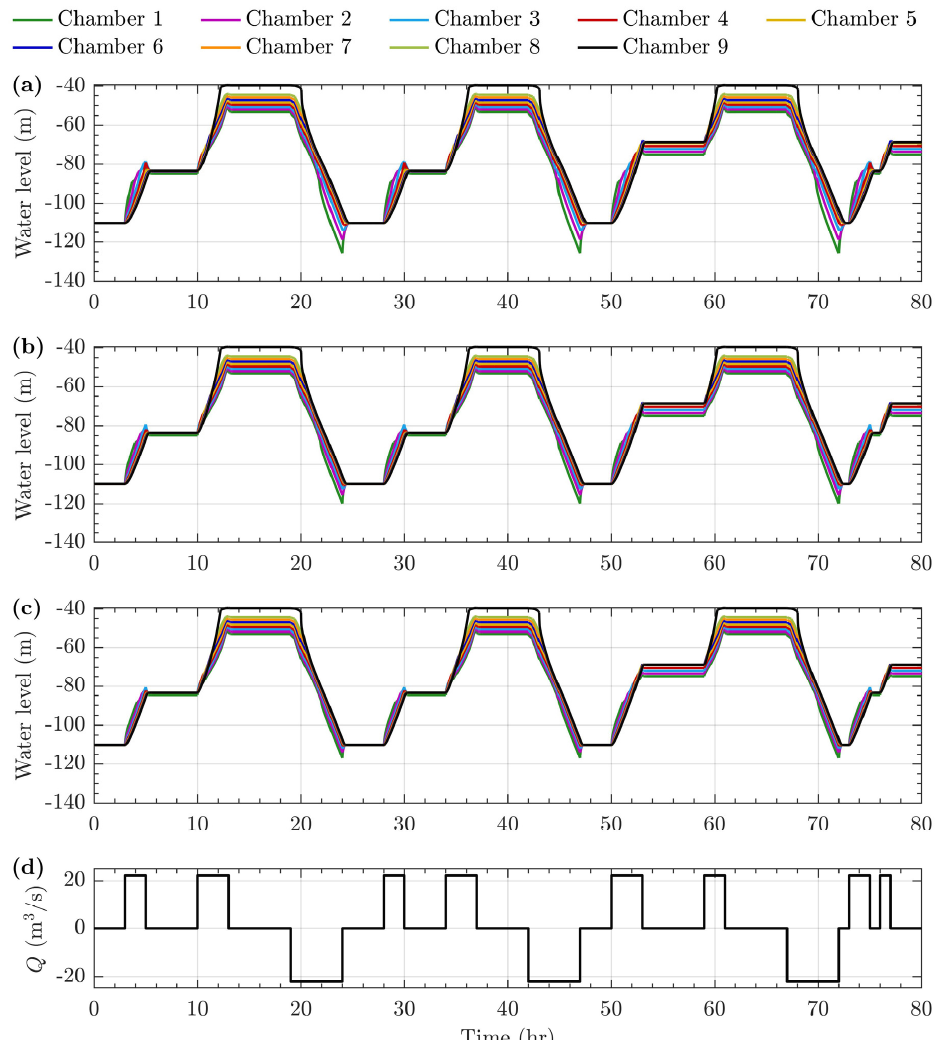
Figure 4. Evolution of the water level in the chambers of the underground reservoir of the UPSH for the winter discharge scenario, Q . The system is only aerated in chamber 9 and successive chambers are connected with two galleries with total cross sectional area of ( a ) 5 m 2 , ( b ) 6 m 2 , and ( c ) 7 m 2 . The corresponding portion of the winter discharge scenario is shown in ( d ). The roughness height in the connecting galleries is 5 cm while the water level is expressed with respect to the ground surface.